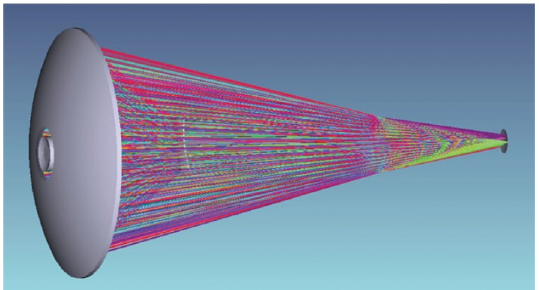
Figure 8: Two-mirror image-transport, magnification M = − 1, as field corrector with predetermined curvature. Both mir- rors are conicoids where the first mirror is convex. This is a field corrector system where the concentric two-mirror pair